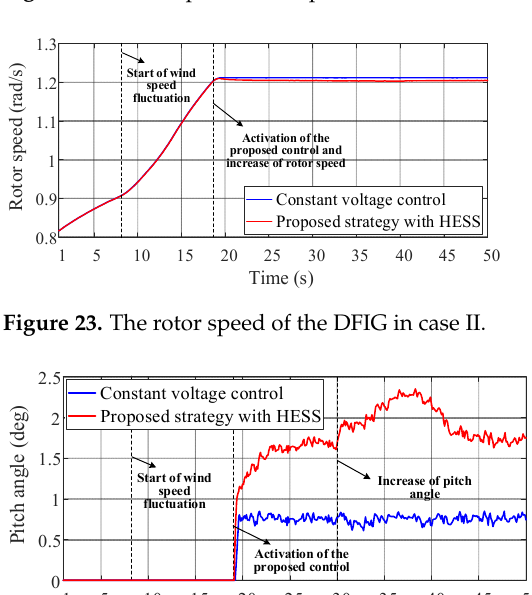
Figure 22. The output reactive power of the DFIG in case II.